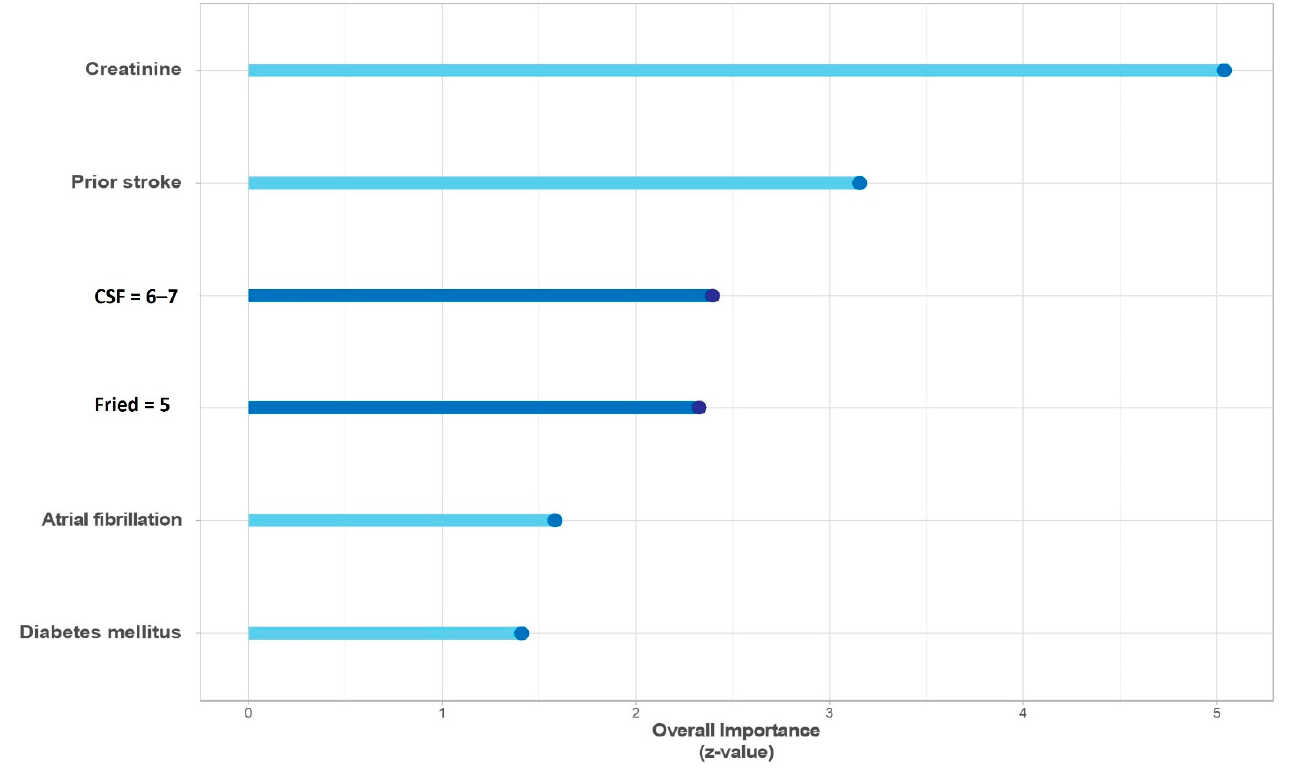
Figure 4. Multivariate model for primary endpoint. Table 2. Multivariate generalized linear models for primary endpoint using frailty scales as cate- gorical.